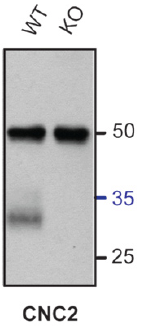
1.2 Size Forms. Ca 1.2 was 1 v 1.2 1